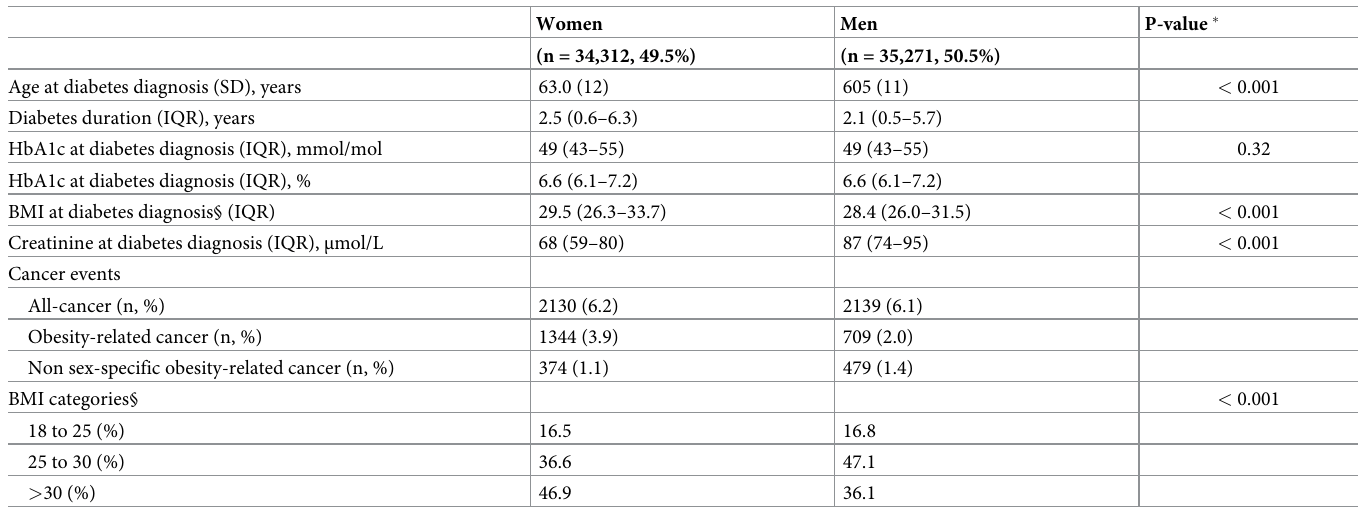
Table 1. Patient